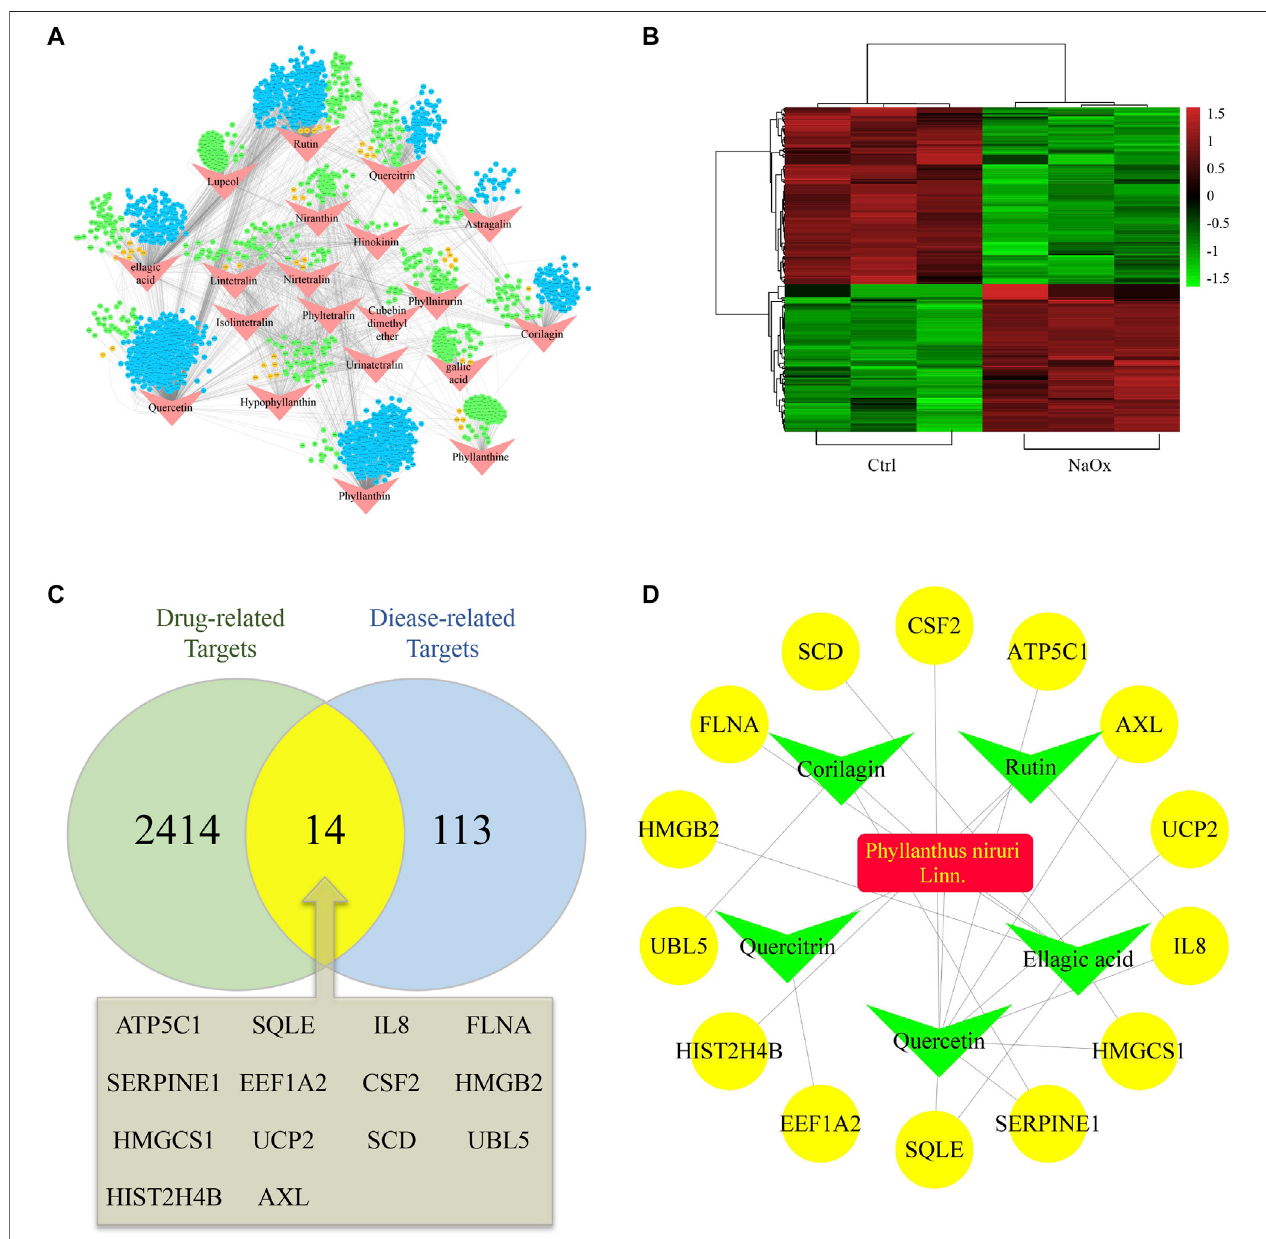
FIGURE 1 | Hub ingredients and targets screening (A) An ingredient-target network and nodes represent ingredients (red) and targets form STITCH (blue), Pharmmapper(green)orboth(orange) (B) Heatmapofpotentialdisease-relatedtargetsonmicroarrayanalysisbetweenHK-2cellsculturedwith(NaOxgroup)orwithout (Ctrl group) NaOx (C) Venn diagram showing the overlap of diease-related (Oxalate-induced renal injury related) targets (blue) and drug-related ( Phyllanthus niruri. L related) targets (green) (D) The active ingredient-predicted therapeutic target network.